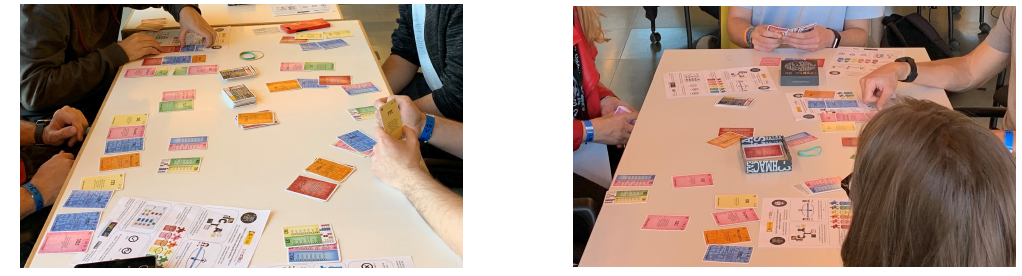
Figure 3. Learners playing Crypto